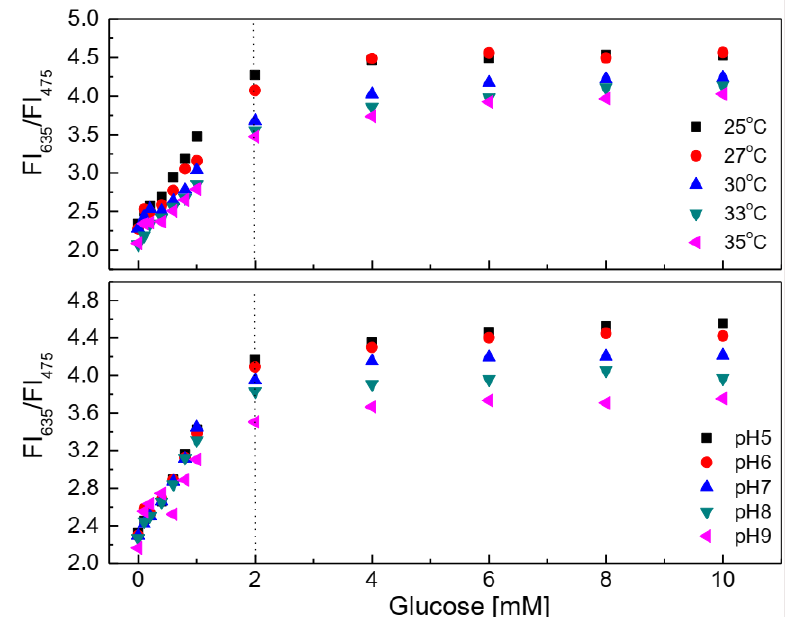
Figure 6. Response of the glucose-sensing membrane at different glucose concentrations in the temperature range of 25–35 ◦ C and the pH range of